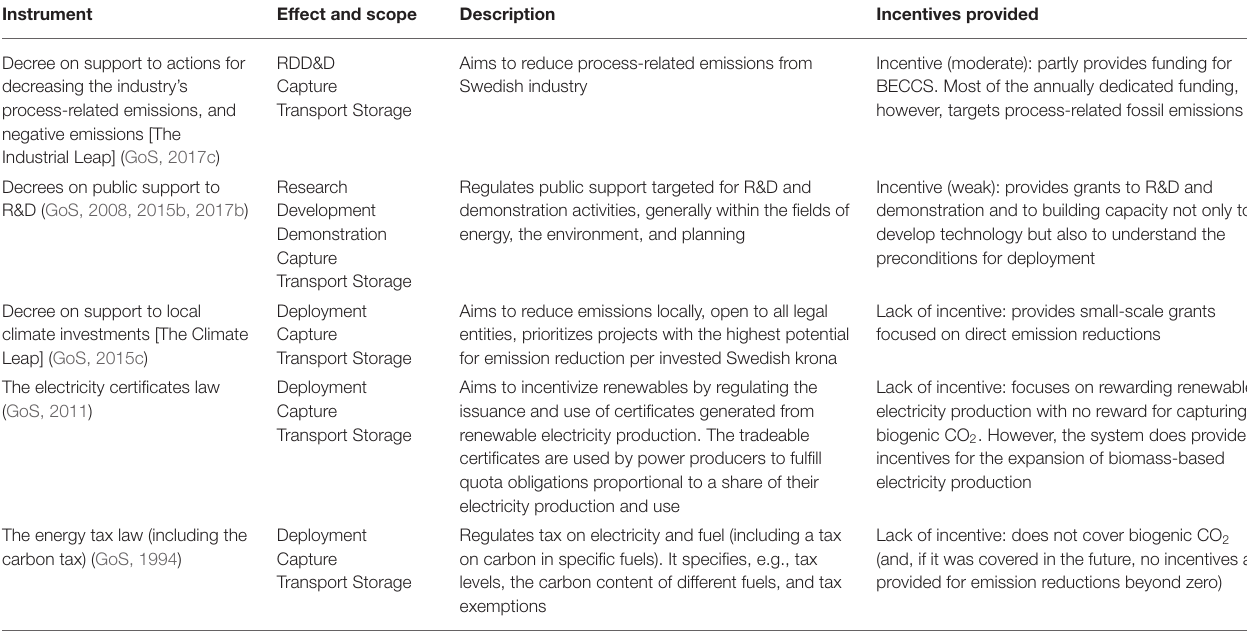
TABLE 6 | National (Swedish) economic policy instruments of direct relevance to BECCS RDD&D, in descending order of